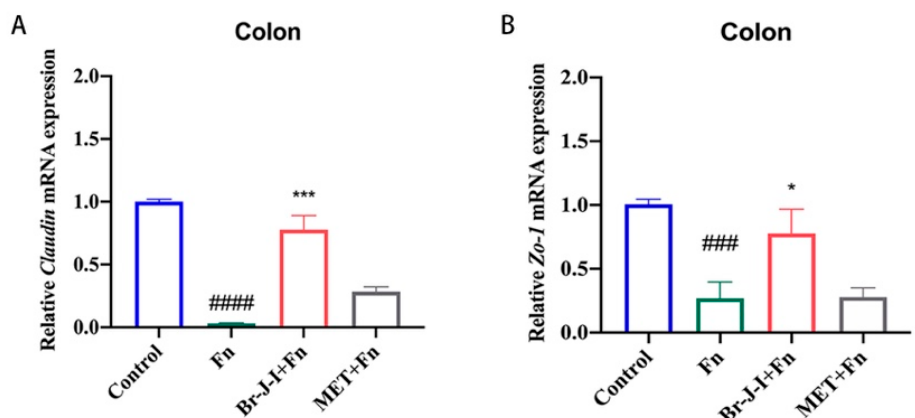
Figure 8. Effect of Br-J-I on the integrity of intestinal mucosa in murine engrafted with CRC and Fn . ( A , B ) Quantification of the effect of Br-J-I on the expression of genes encoding the tight junction proteins Claudin ( A ), and ZO-1 ( B ) in the colon tissues of the CRC cells-engrafted mice with or without Fn colonization in the presence of Br-J-I (10 mg/kg) and MET (40 mg/kg). Data are expressed as mean ± SEM. * p < 0.05, *** p < 0.001, vs. Fn group. ### p < 0.001, #### p < 0.0001, vs. Control.